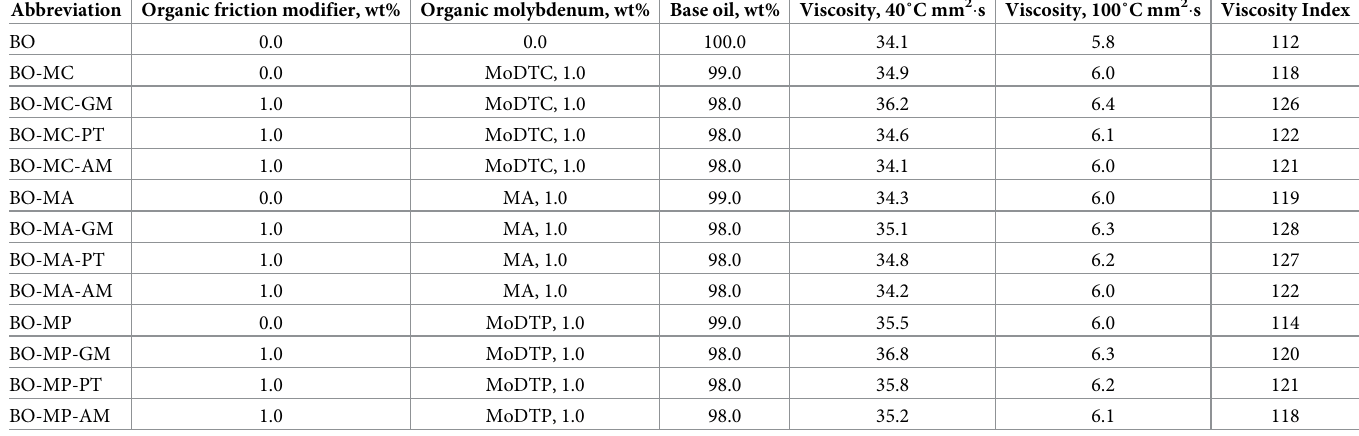
Table 2. Test oil